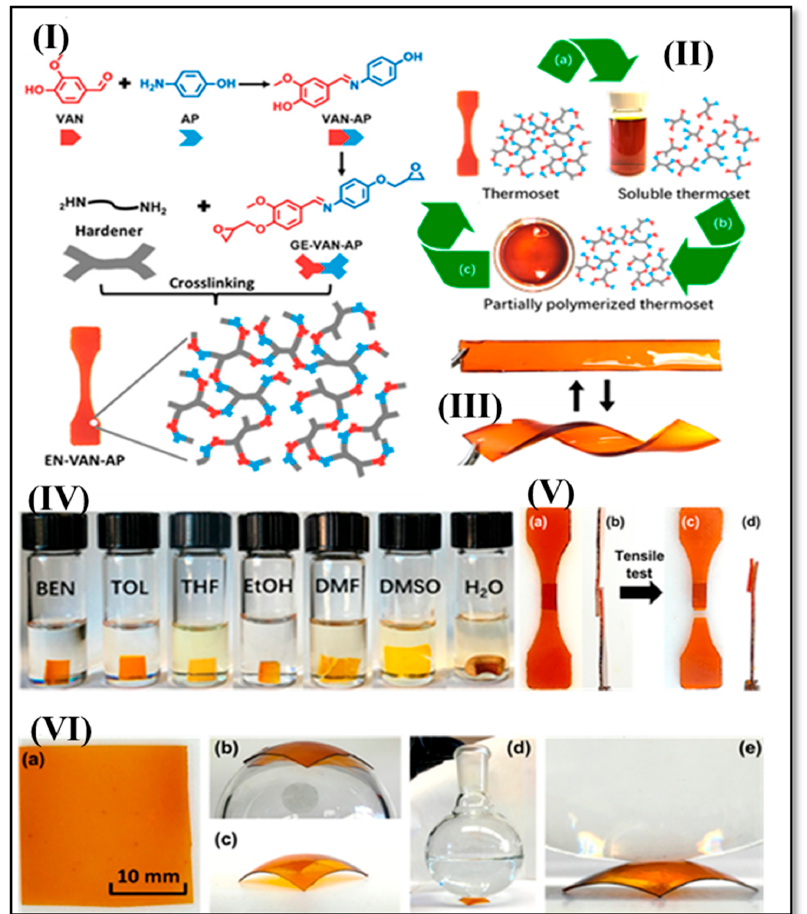
Figure 4. ( I ) Synthesis method of epoxy resin; ( II ) chemical reprocessing stages of cured epoxy resins: (a) solubilized in DMF and HCl solvents; (b) partly polymerized viscous solution; (c) viscous solution restored cured epoxy resin; ( III ) malleability; ( IV ) solvent resistance; ( V ) weldability of the